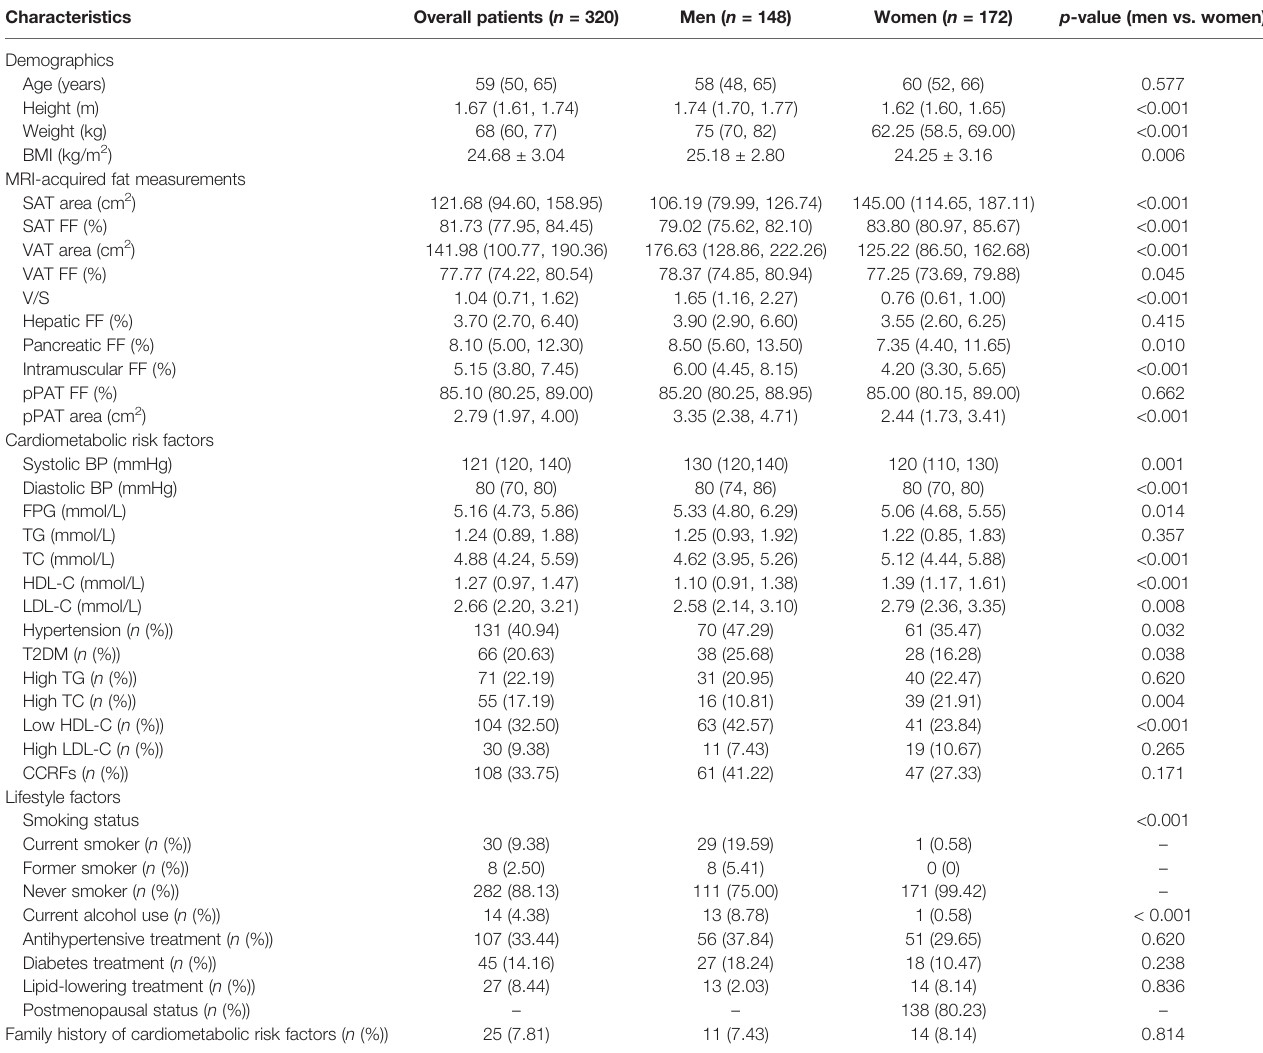
TABLE 1 | Clinical characteristics of the study subjects.